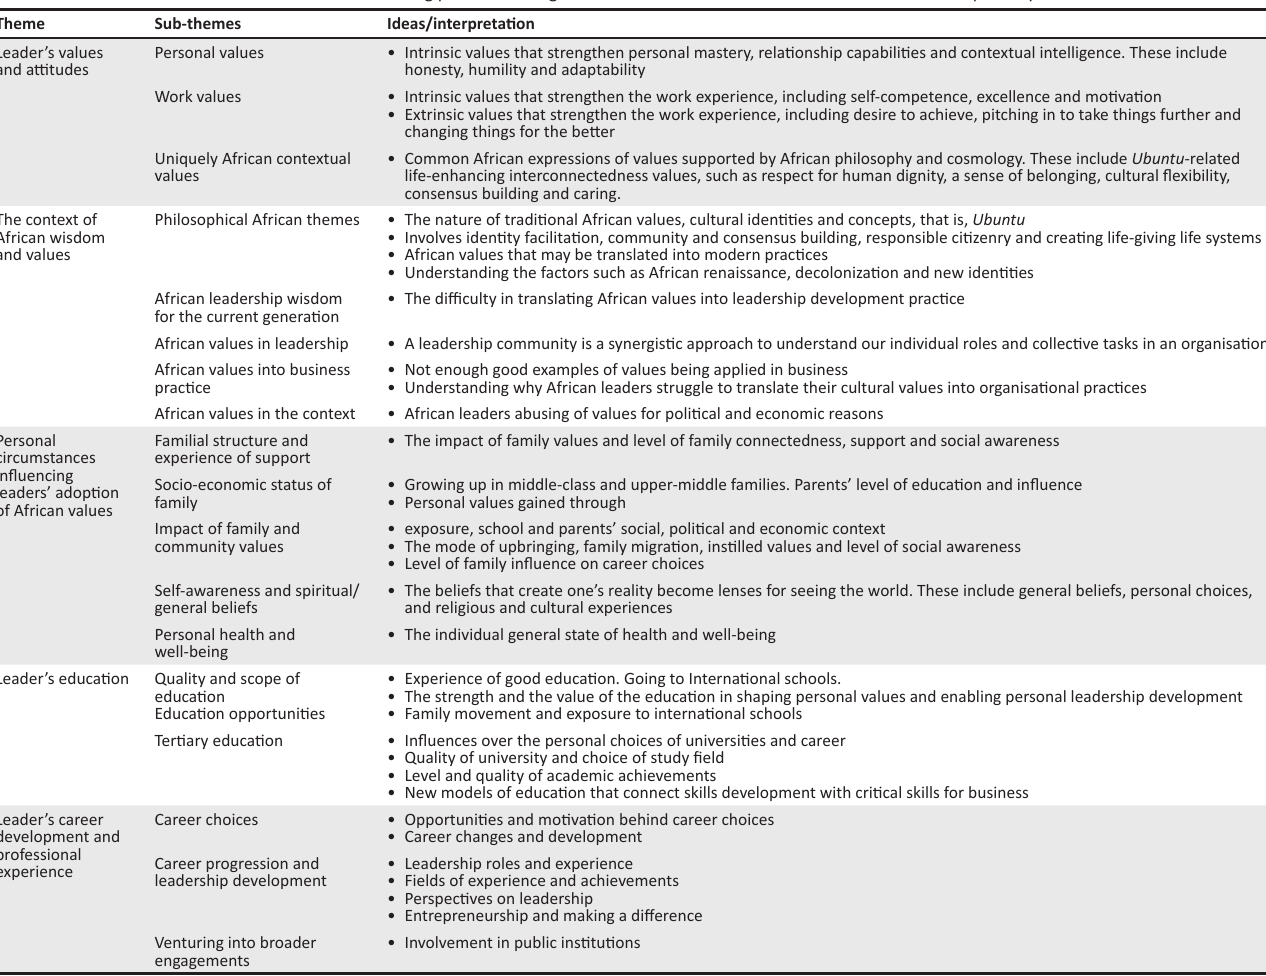
TABLE 1: Themes and subthemes derived from the coding process relating to the use of shared African human values in the workplace by the three African